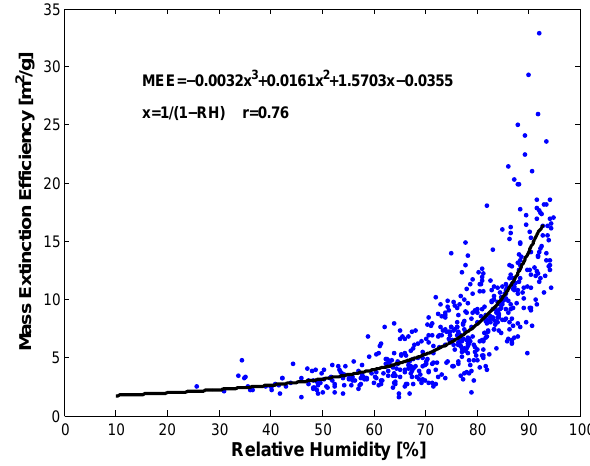
Fig. 10. The relationship between daily mean mass extinction ef- ficiency (MEE) and relative humidity in summer 2003-2008. The black curve is the fitting line of the data. The correlation coefficient between MEE and x is shown as the variable “ r